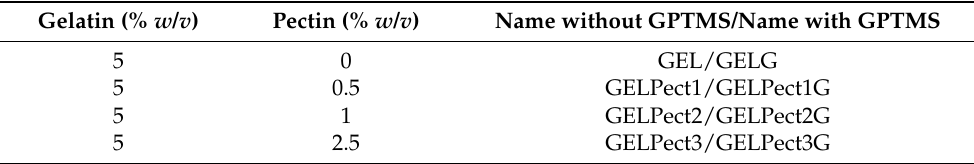
Table 1. Composition of gelatin-pectin formulations in